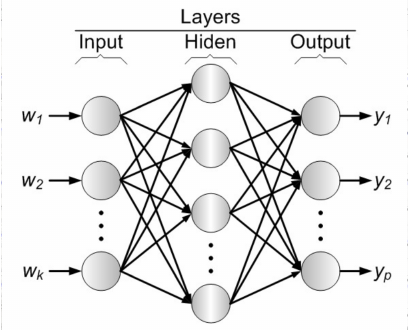
Figure 2. Multilayer perceptron